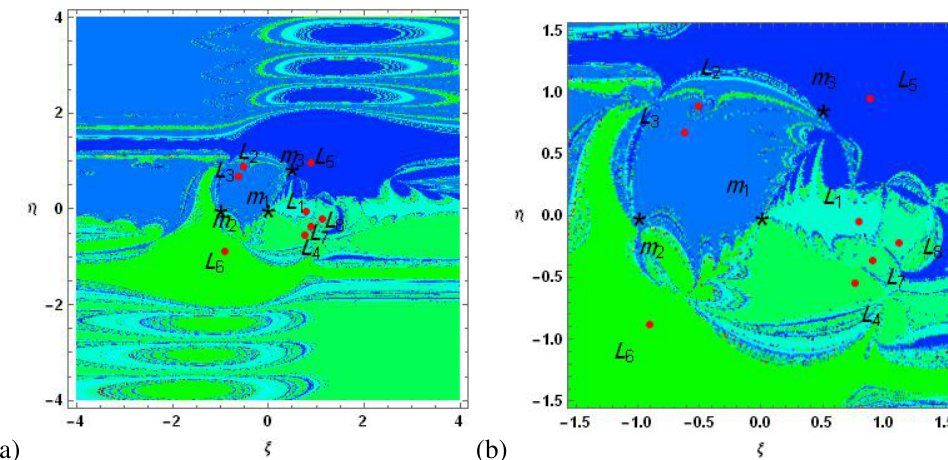
Fig. 8 (a): The basin of attraction for the solar radiation pressure case. (b): Zoomed image of (a) near the lagrangian configuration.